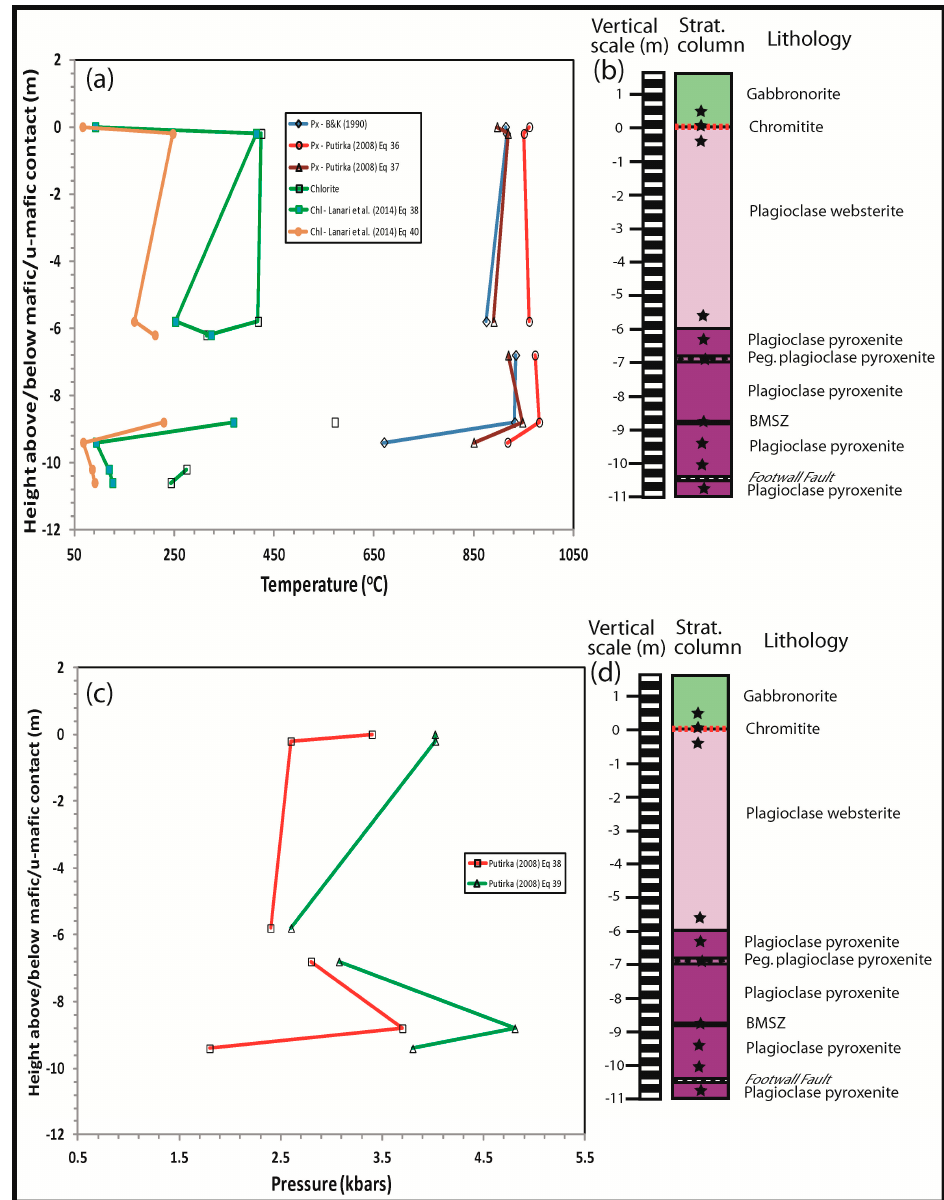
Figure 20. ( a ) Plot of temperatures obtained from chlorite as well as from two-pyroxene thermometry of versus height across the MSZ. Corresponding lithologic units are shown in ( b ) using the equations of Brey and Kohler (1986) [65] and Putirka (2008) [66]. Lower temperatures for chlorites calculated using the equations of Lanari et al. [64] and relatively higher temperatures for chlorites were calculated using the equation of Cathelineau [62]. ( a ) Plot of pressures obtained from two-pyroxene thermometry of versus height across the MSZ. Corresponding lithologic units are shown in ( b ). Variation of calculated pressures based on the Equations (38) and (19) of Putirka (2008) [66] across the MSZ. Pressures that were calculated using Equation (39) are slightly higher than those calculated using Equation